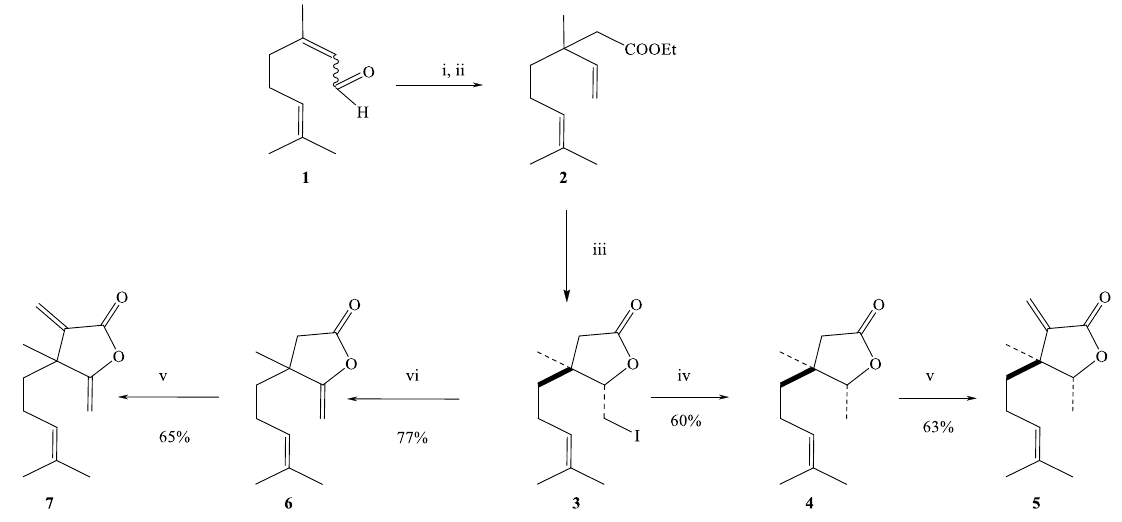
Figure 1. Synthesis of the studied lactones. (i) NaBH 4 in MeOH; (ii) CH 3 C(OEt) 3 , EtCOOH, 138 ◦ C; (iii) first KOH, MeOH then I 2 , NaHCO 3 and isolation of trans- δ -iodo- γ -lactone on column chromatography; (iv) TBTH; (v) two-step synthesis a) MMC in DMF, b) N-methyl-N-phenylamine, 30% HCHO, CH 3 COOH, CH 3 COONa; (vi) DBU, CH 2 Cl 2 . Citral ( 1 ); γ , δ -unsaturated ethyl ester ( 2 ); δ -iodo- γ -lactone ( 3 ); β , γ -dimethyllactone ( 4 ); α -methylenelactone ( 5 ); γ -methylenelactone ( 6 ); α , γ -dimethylenelactone ( 7 ).